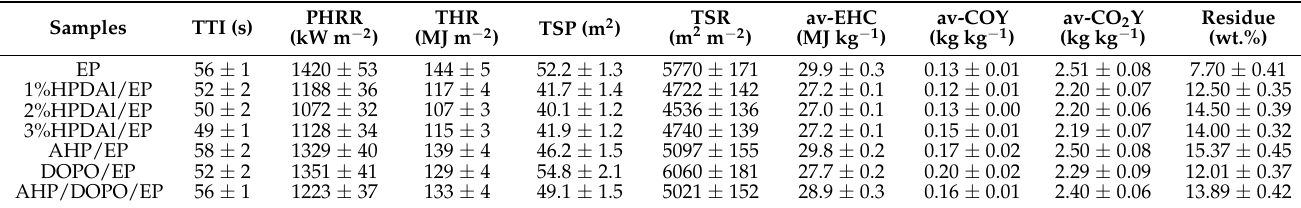
Table 3. Combustion parameters collected in cone calorimetry